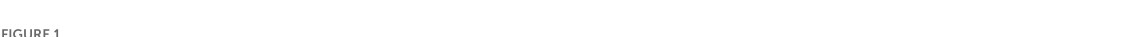
FIGURE1 defined as a difference between time spent (t 2 ) in the cocaine-paired chamber during post-conditioning minus time spent (t 1 ) in the same chamber but during pre-conditioning (pre-test). (C,G) There were no pre-existing differences in the time spent in the cocaine- and saline-paired chambers during pre-test between future vehicle (Veh)- and prazosin (Praz)-treated subjects. (D,E) Intra-VTA microinfusion of prazosin attenuated the acquisition of CPP induced by one ( D for CPP score and E for delta score) and two ( H for CPP score and I for delta score) cocaine (20 mg/kg, i.p.) conditionings. (J) Localization of histologically verified cannula placements. Data are presented as individual data points as well as the mean and SEM. ∗∗ p < 0.01, ∗∗∗ p < 0.001, Newman–Keuls post-hoc test vs. Praz 0 µ